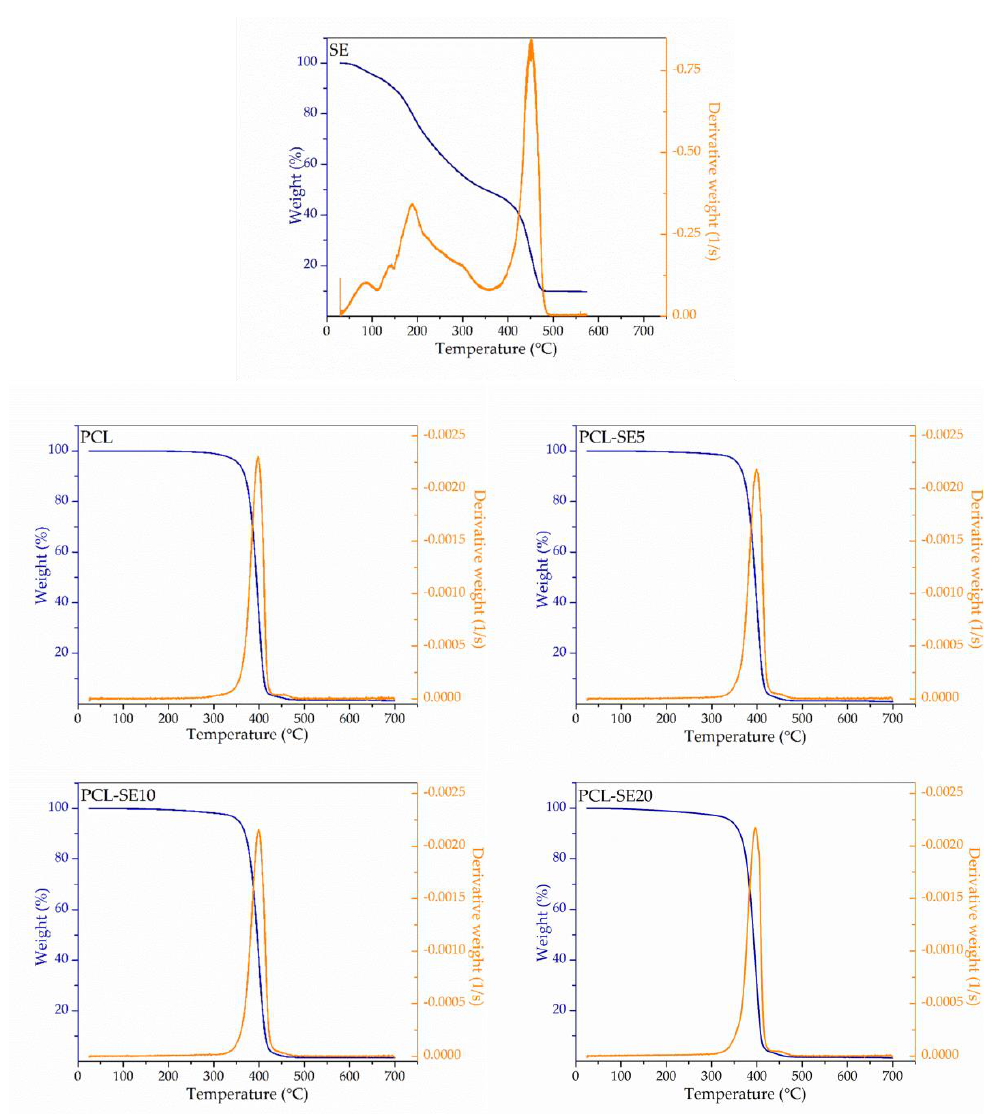
Figure 3. Thermogravimetric curves of the free sage extract (SE) and the poly( ε -caprolactone) 3 (PCL)-based